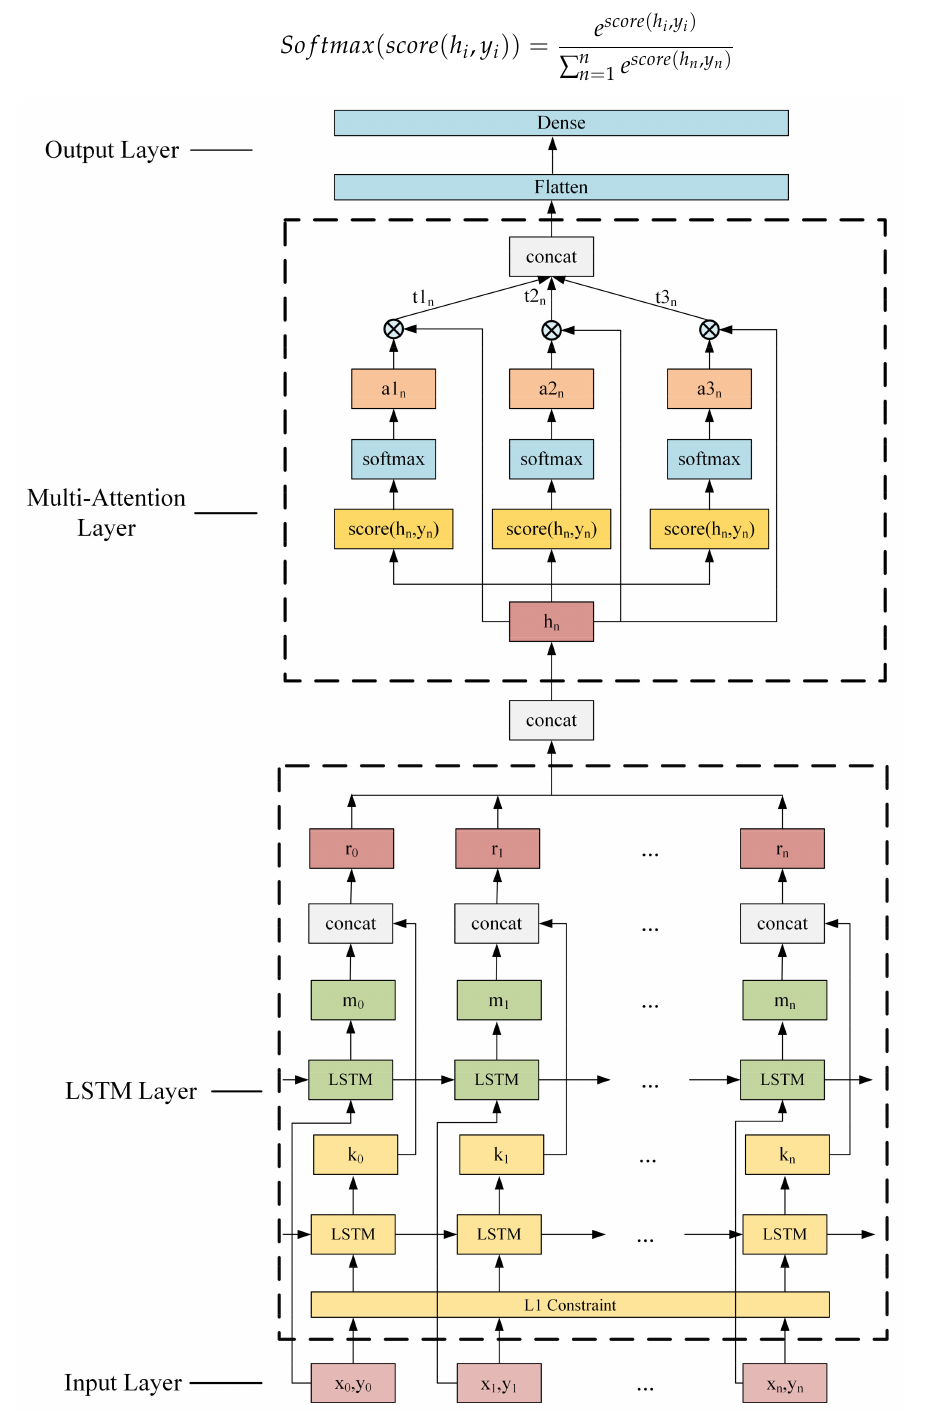
Figure 7. MA-LSTM model structure for TEC